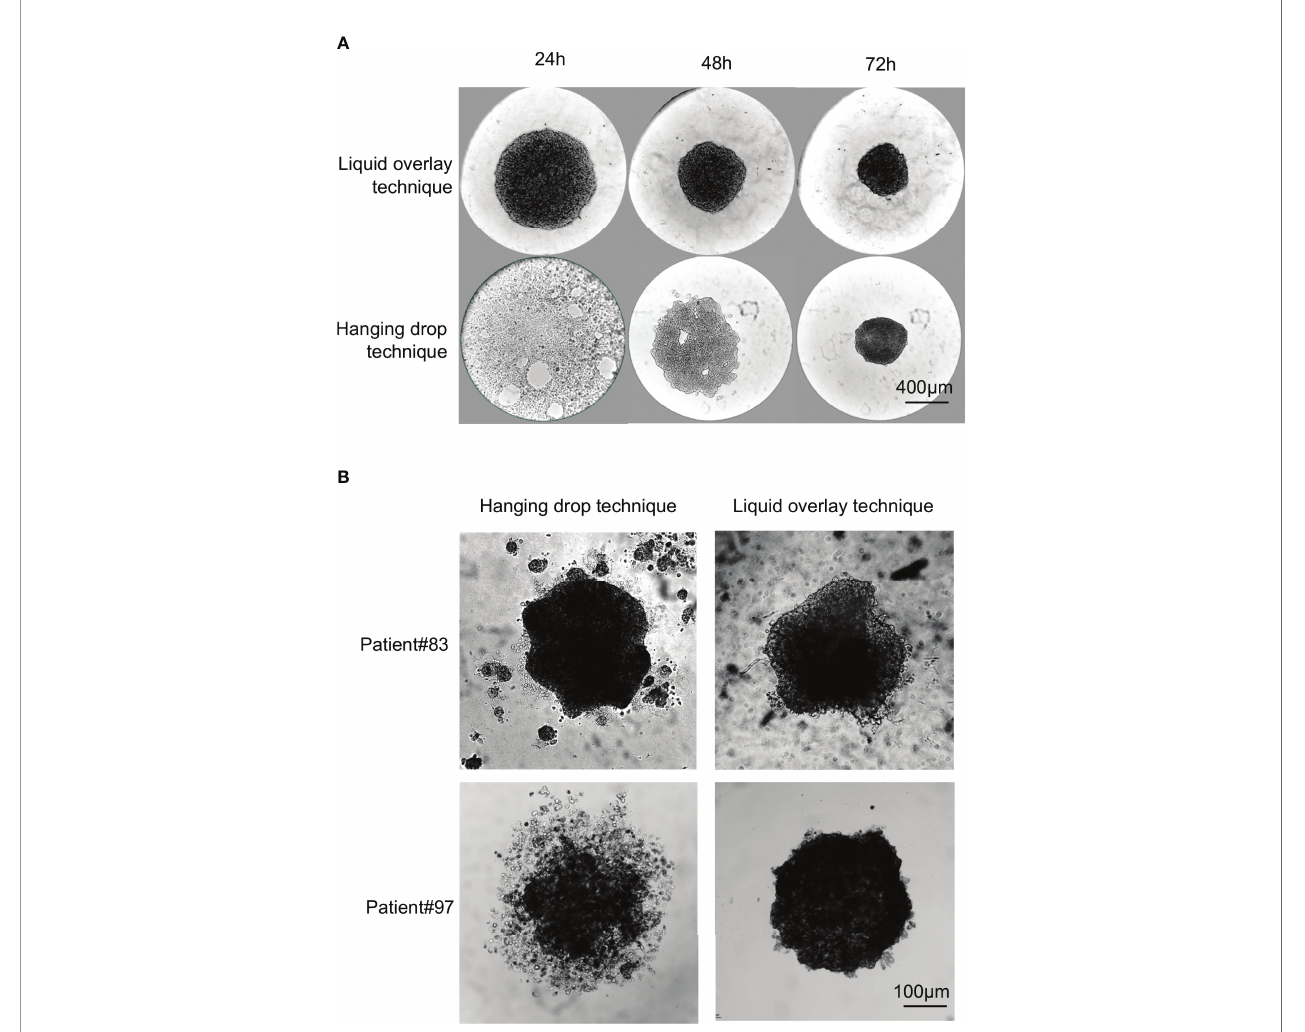
FIGURE 2 | Comparison of spheroid formation from established long-term cell lines and primary lines using the hanging drop or liquid overlay techniques. 10,000 cells from RCC7 cell line or from primary cultures were seeded in droplets and left hanging from the lid of a petri dish (Hanging drop technique) or in the wells of a 96-wells cell-repellent plate (Liquid overlay technique). (A) Representative bright fi eld images of RCC7 spheroid formation using the hanging drop technique or the liquid overlay technique taken every 24h for 72h post-seeding. (B) Representative bright fi eld images of spheroid formation from primary cultures after 72h of culture using the hanging drop technique or the liquid overlay